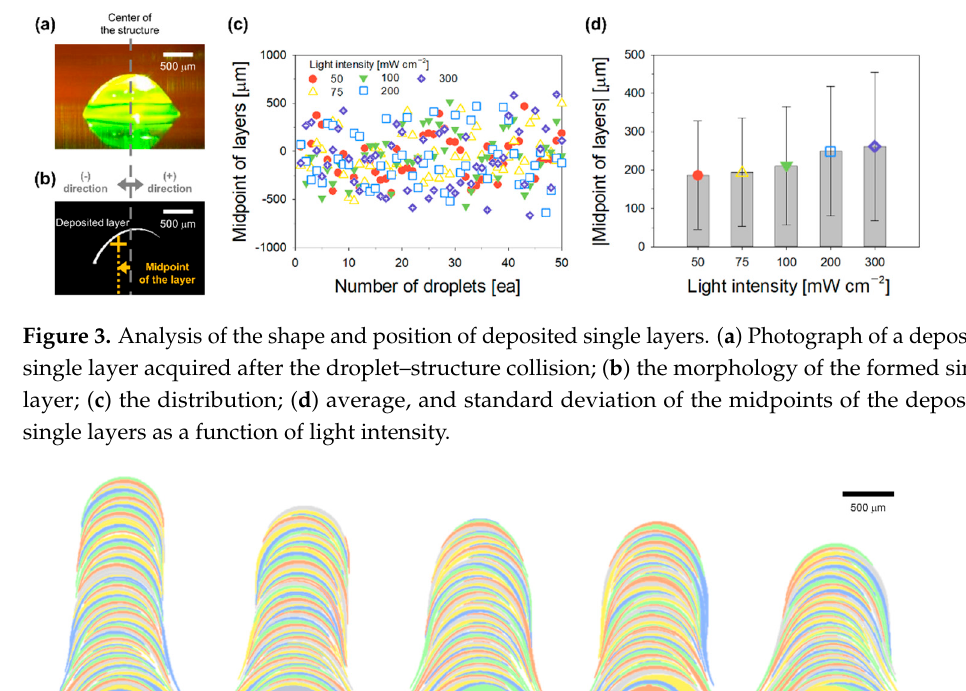
Figure 3. Analysis of the shape and position of deposited single layers. ( a ) Photograph of a deposited single layer acquired after the droplet–structure collision; ( b ) the morphology of the formed single layer; ( c ) the distribution; ( d ) average, and standard deviation of the midpoints of the deposited single layers as a function of light intensity.